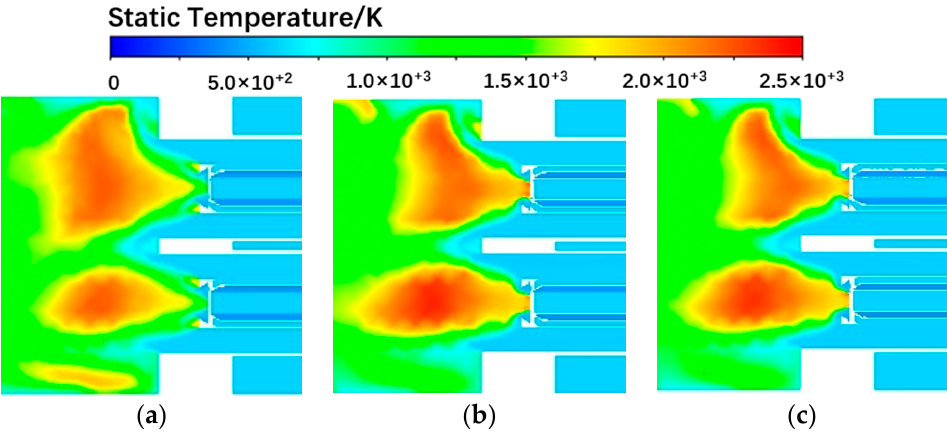
Figure 8. Calculation results of temperature distribution of each mode in startup stage. ( a ) Diffusion; ( b ) Sub-pilot premix; ( c ) Pilot premix.